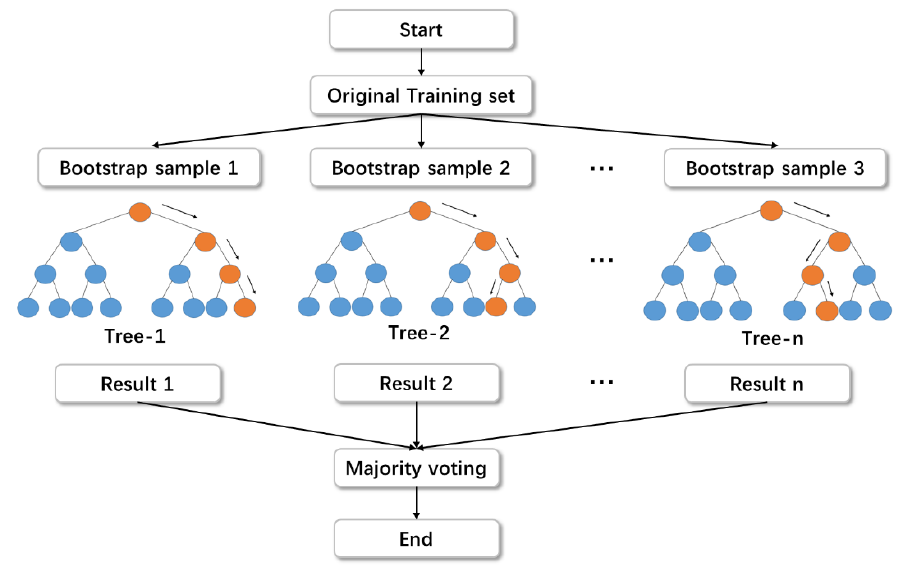
Figure 2. Typical structure of random forests.